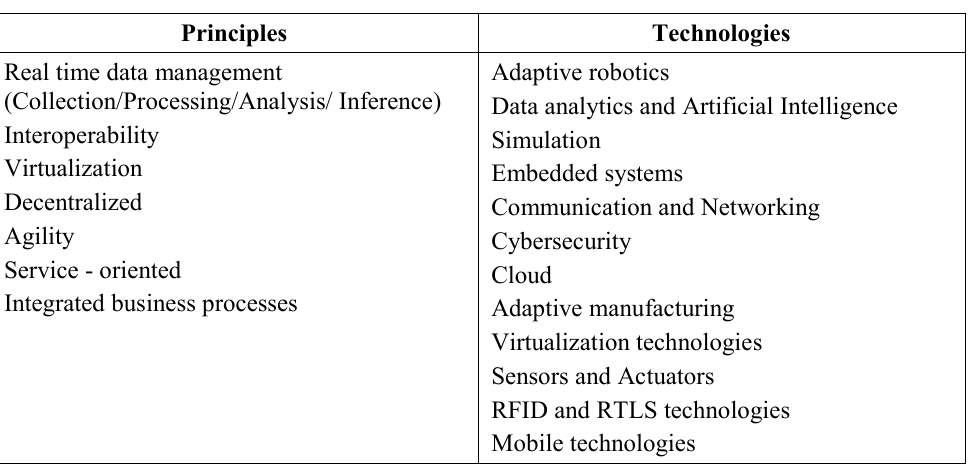
Table 1. Industry 4.0 Principles and Technologies (Akdil, Ustundag & Cevikcan,